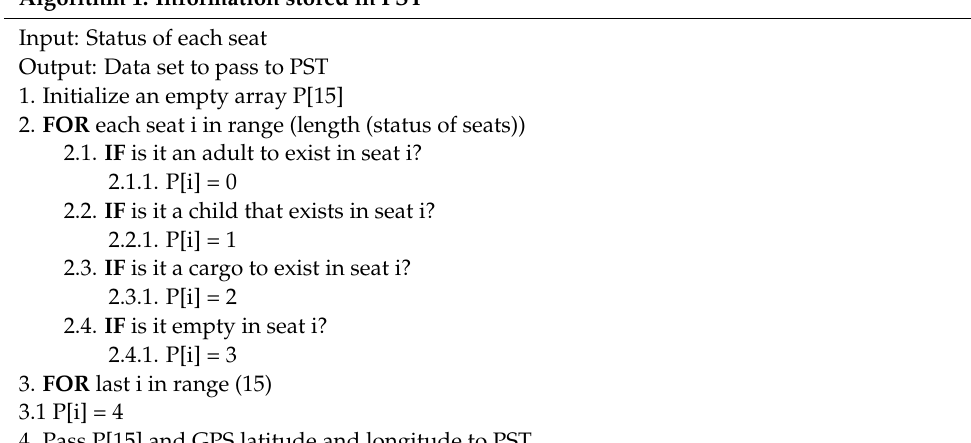
Algorithm 1. Information stored in PST